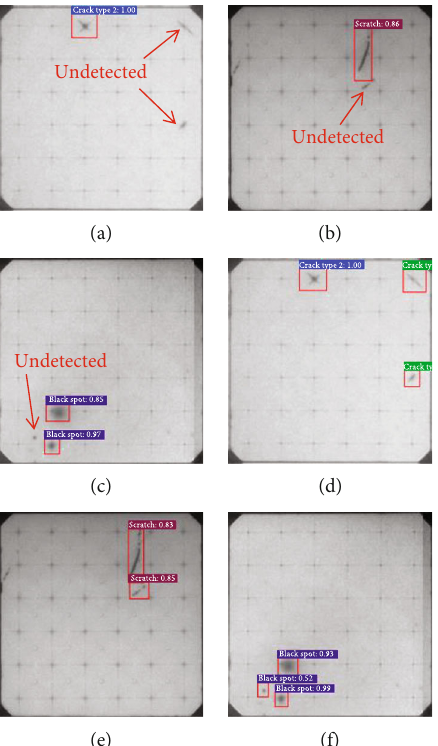
Figure 15: Comparison of test results before and after the model improvement: (a), (b), and (c) show the e ff ect before the improvement; (d), (e), and (f) show the e ff ect after the